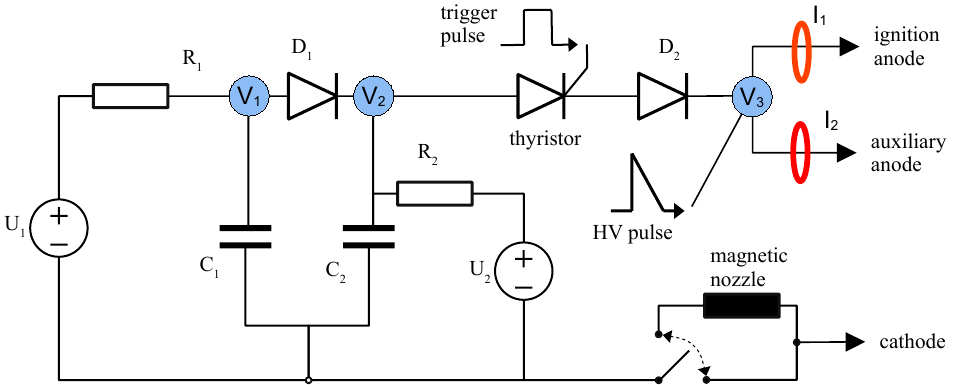
Figure 3. Schematic of the power supply unit based on a dual stage capacitor discharge network with blocking diodes. The measurement points for the pulse processing unit (PPU) voltages V 1 − V 3 (blue circles) and the currents I 1 and I 2 (red loops) are shown. The magnetic nozzle (air coil) can be switched in series to the cathode instead of a direct connection of the cathode to ground (switch